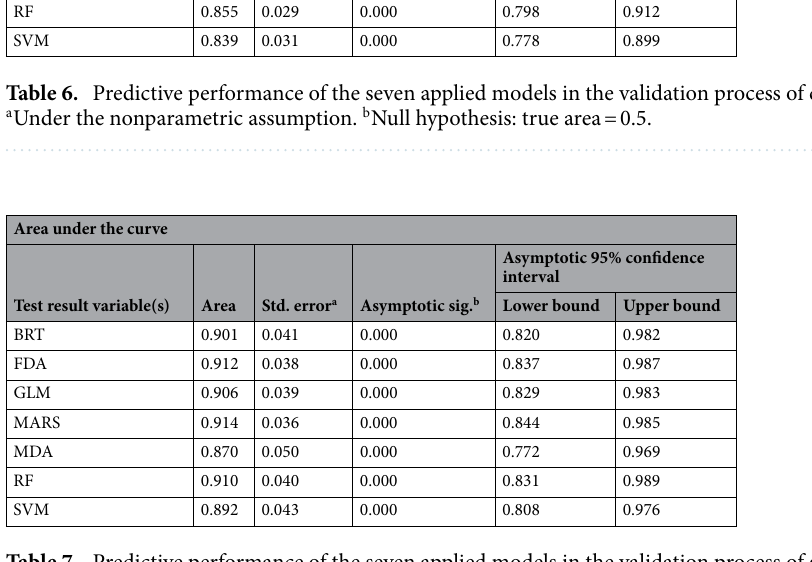
Table 7. Predictive performance of the seven applied models in the validation process of gully heads 2021. a Under the nonparametric assumption. b Null hypothesis: true area = 0.5.